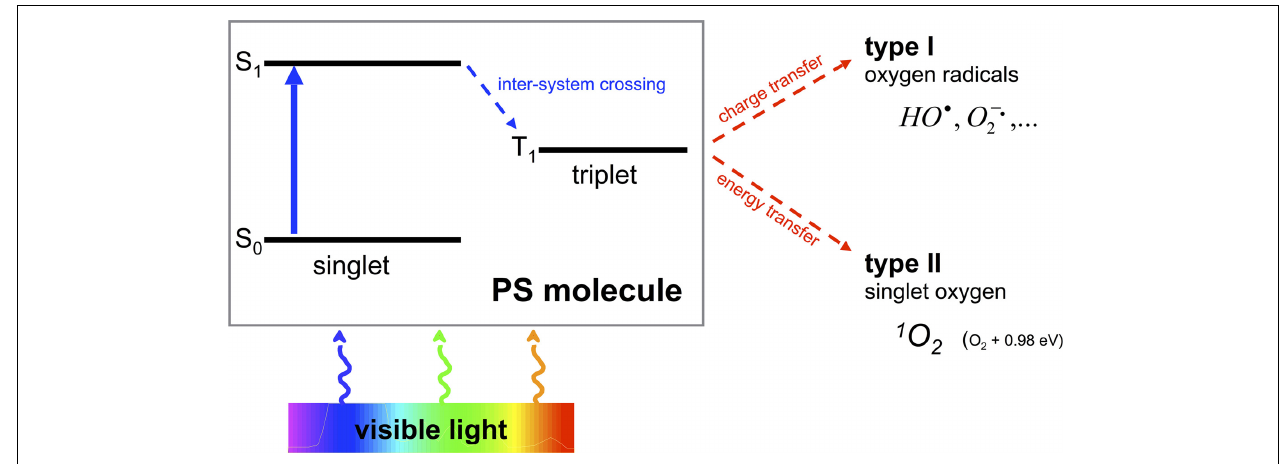
FIGURE 1 | Type I and type II processes of aPDT. Visible light of an appropriate wavelength is absorbed by the PS molecule by what the PS changes from its initial ground state S 0 to an energetically excited state S 1 . Thereupon the PS is able to transition within the molecule from its singlet to